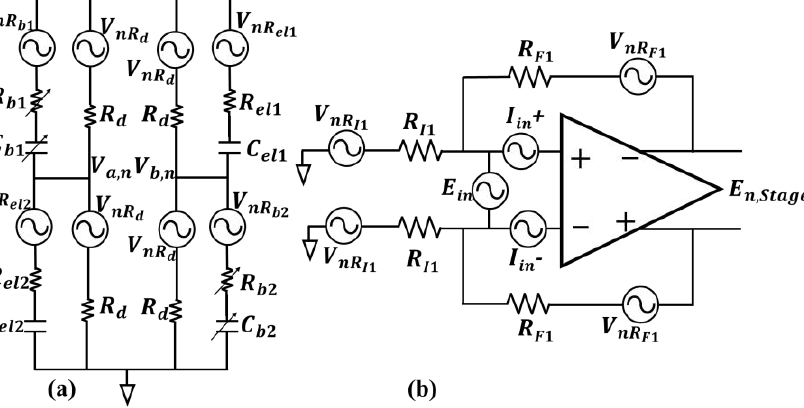
Figure 3. Utilized noise models for the two primary noise contributing blocks; ( a ) the bridge as the differential sensing unit, with the series RC model for the capacitive transducers and balancing networks, all the noise sources in the bridge are thermal type ( b ) differential amplification stage with the associated thermal noise sources for the peripheral resistors, and input-referred current and voltage noise sources of the Opamp.